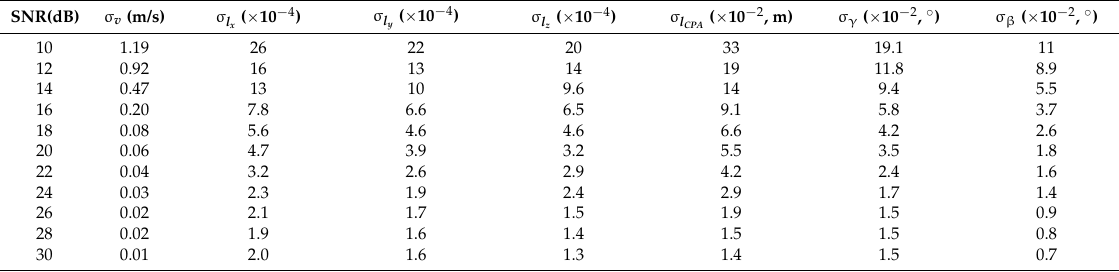
Table 1. Estimation variance of target motion